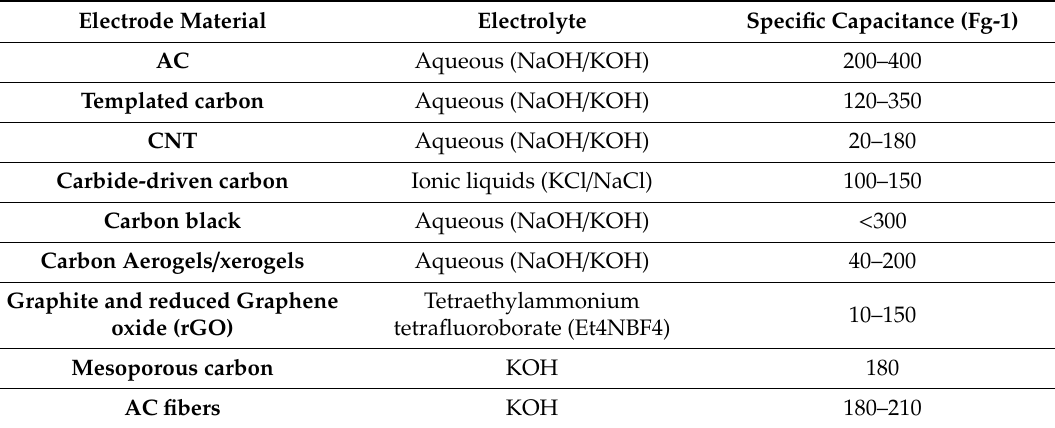
Table 5. Various ELDC electrode materials, electrolytes, and their specific capacitance [59]. Electrode